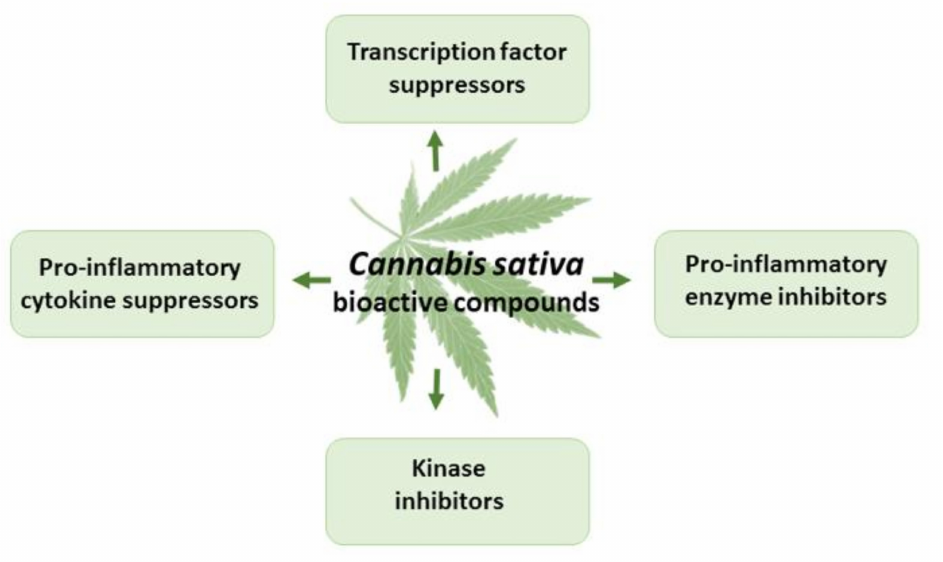
Figure 5. The effects of THC and CBD in